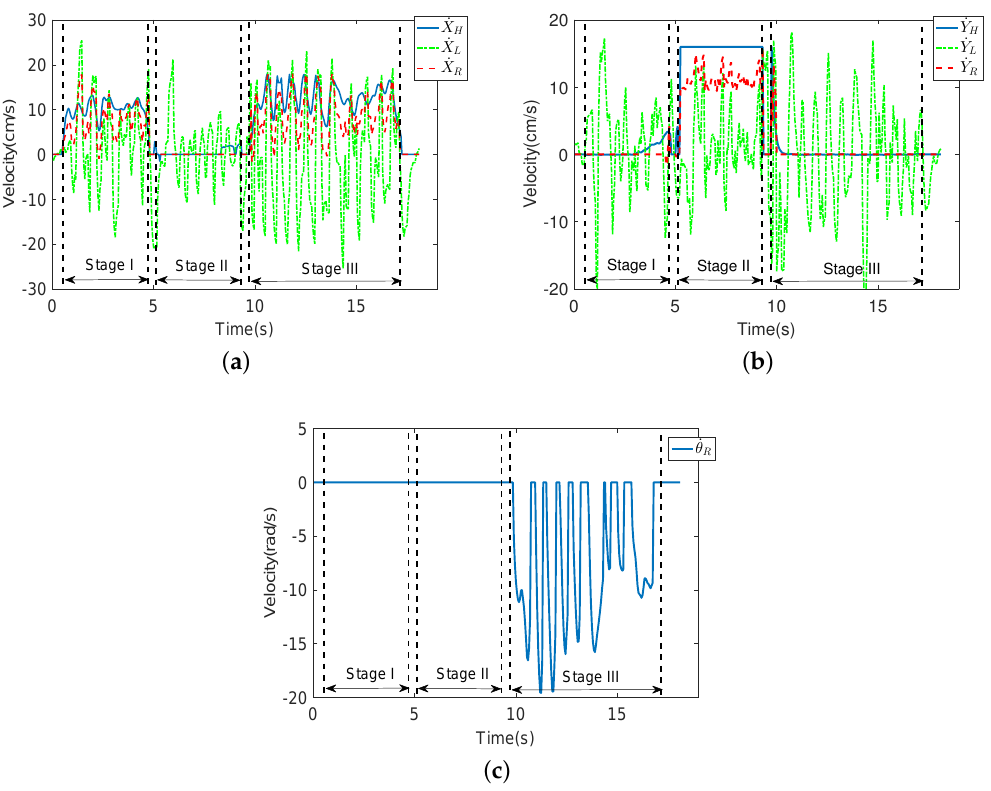
Figure 10. The results of Compliance Control Experiment II. In this experiment, the user goes straight (Stage I) → goes to the left (Stage II) → follows the curve (Stage III). ( a ) The velocities in the X-axis. ( b ) The velocities in the Y-axis. ( c ) The angular velocity of the